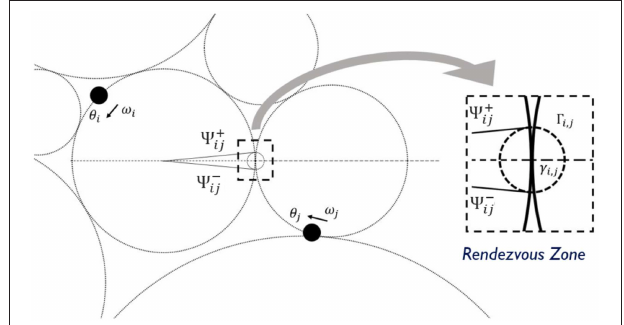
FIGURE 4 | The details of a rendezvous zone Ŵ i , j with the entering and the exiting phases 9 − i , j and 9 + i , j . The shape of the rendezvous zone may vary according to the states of the